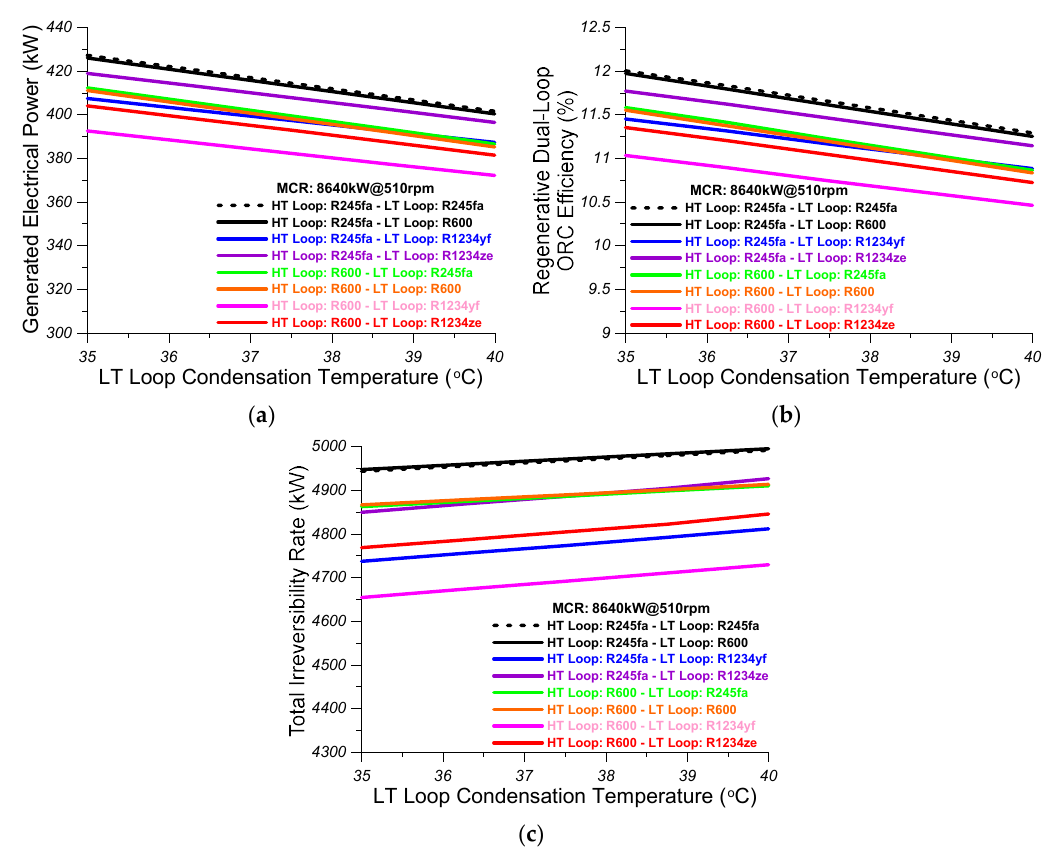
Figure 15. (a) Effect of the condensation temperature of the LT loop on the generated electric power of the regenerative dual-loop ORC; (b) Effect of the condensation temperature of the LT loop on the thermal efficiency; (c) Effect of the condensation temperature of the LT loop on the total irreversibility rate of the regenerative dual-loop ORC. Results are given for all the pairs of organic mediums that are examined in the present study.